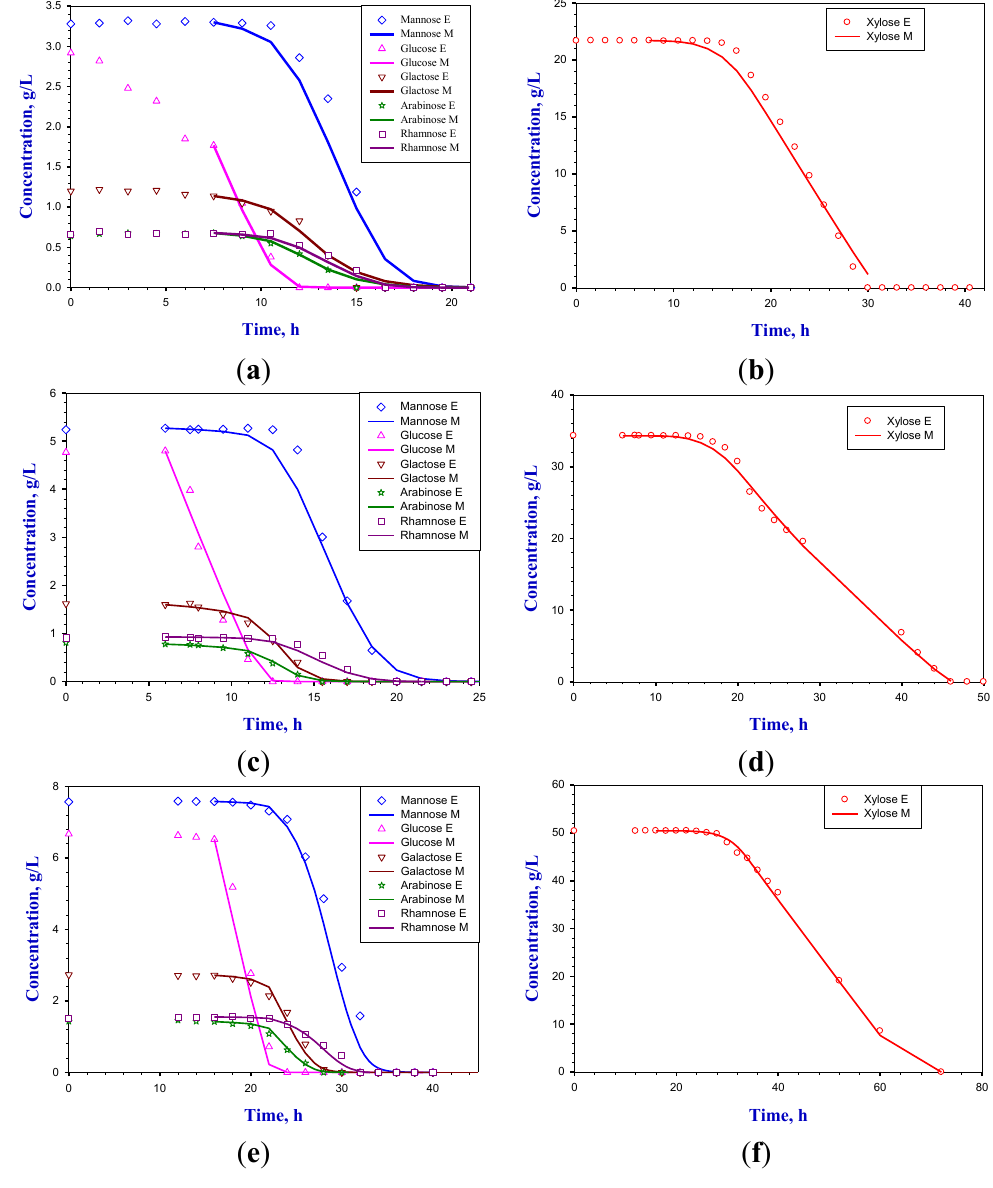
Figure 3. Experimental data and model results of monosaccharides utilizations by recombinant E. coli FBWHR during concentrated hot-water wood extract hydrolyzate